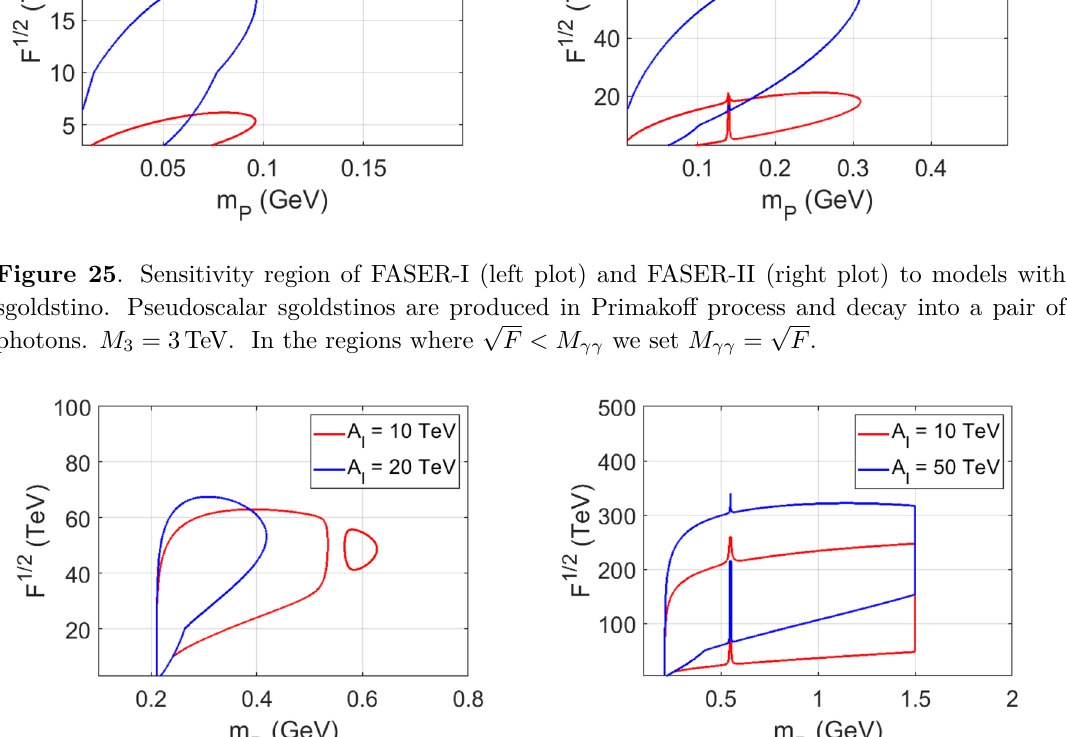
Figure 26 . The regions to be tested with muon pair signature at FASER-I (left panel) and FASER- II (right panel). M 3 = 3 TeV. In the regions where